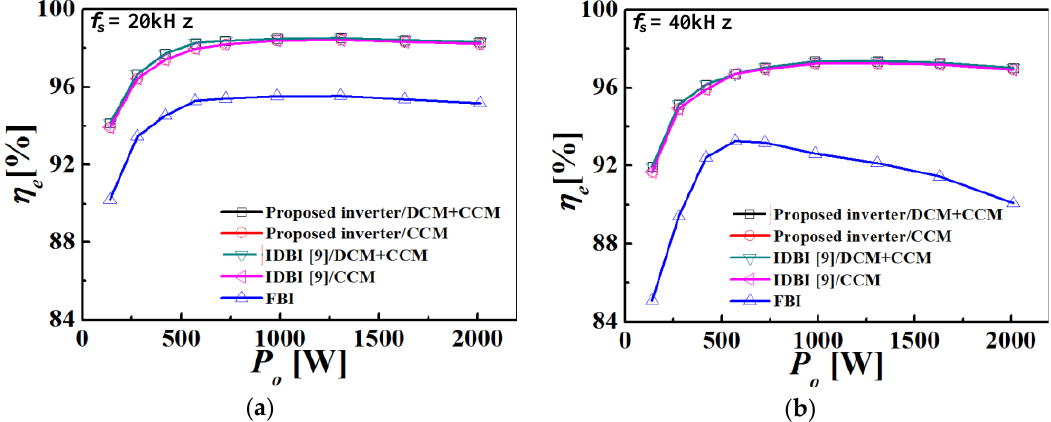
Figure 11. η e vs. P o for the experimental inverters operating at ( a ) f s = 20 kHz and ( b ) f s = 40 kHz: measured at V in = 400 V DC , V grid = 220 V AC /60 Hz, and Q o = 0 VAR. The power loss P DSP in the control circuit was included in η e measurement.